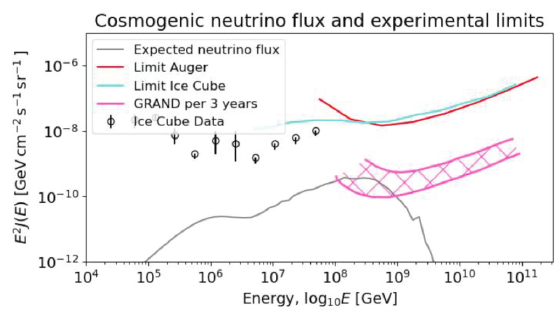
Figure 2. The predicted flux of cosmogenic neutrinos for a com- bined fit above the ankle, compared to the IceCube neutrino flux [8], the GRAND sensitivity after three years of operation [9] and to the limits for the cosmogenic neutrinos by the Pierre Auger [10] and IceCube [11]